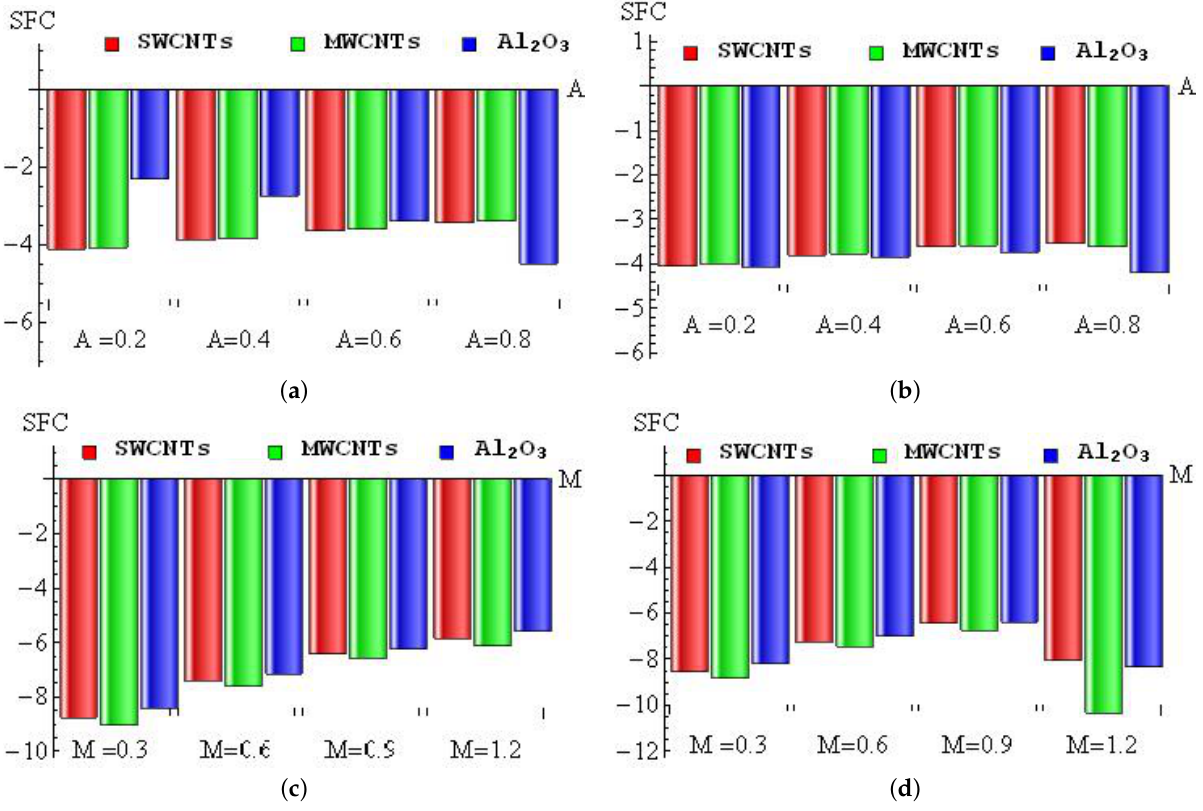
Figure 10. The diminishing percentage of SFC for A ( a , b ) and M ( c , d ) with convective heating ( a , c ) and convective cooling ( b , d )